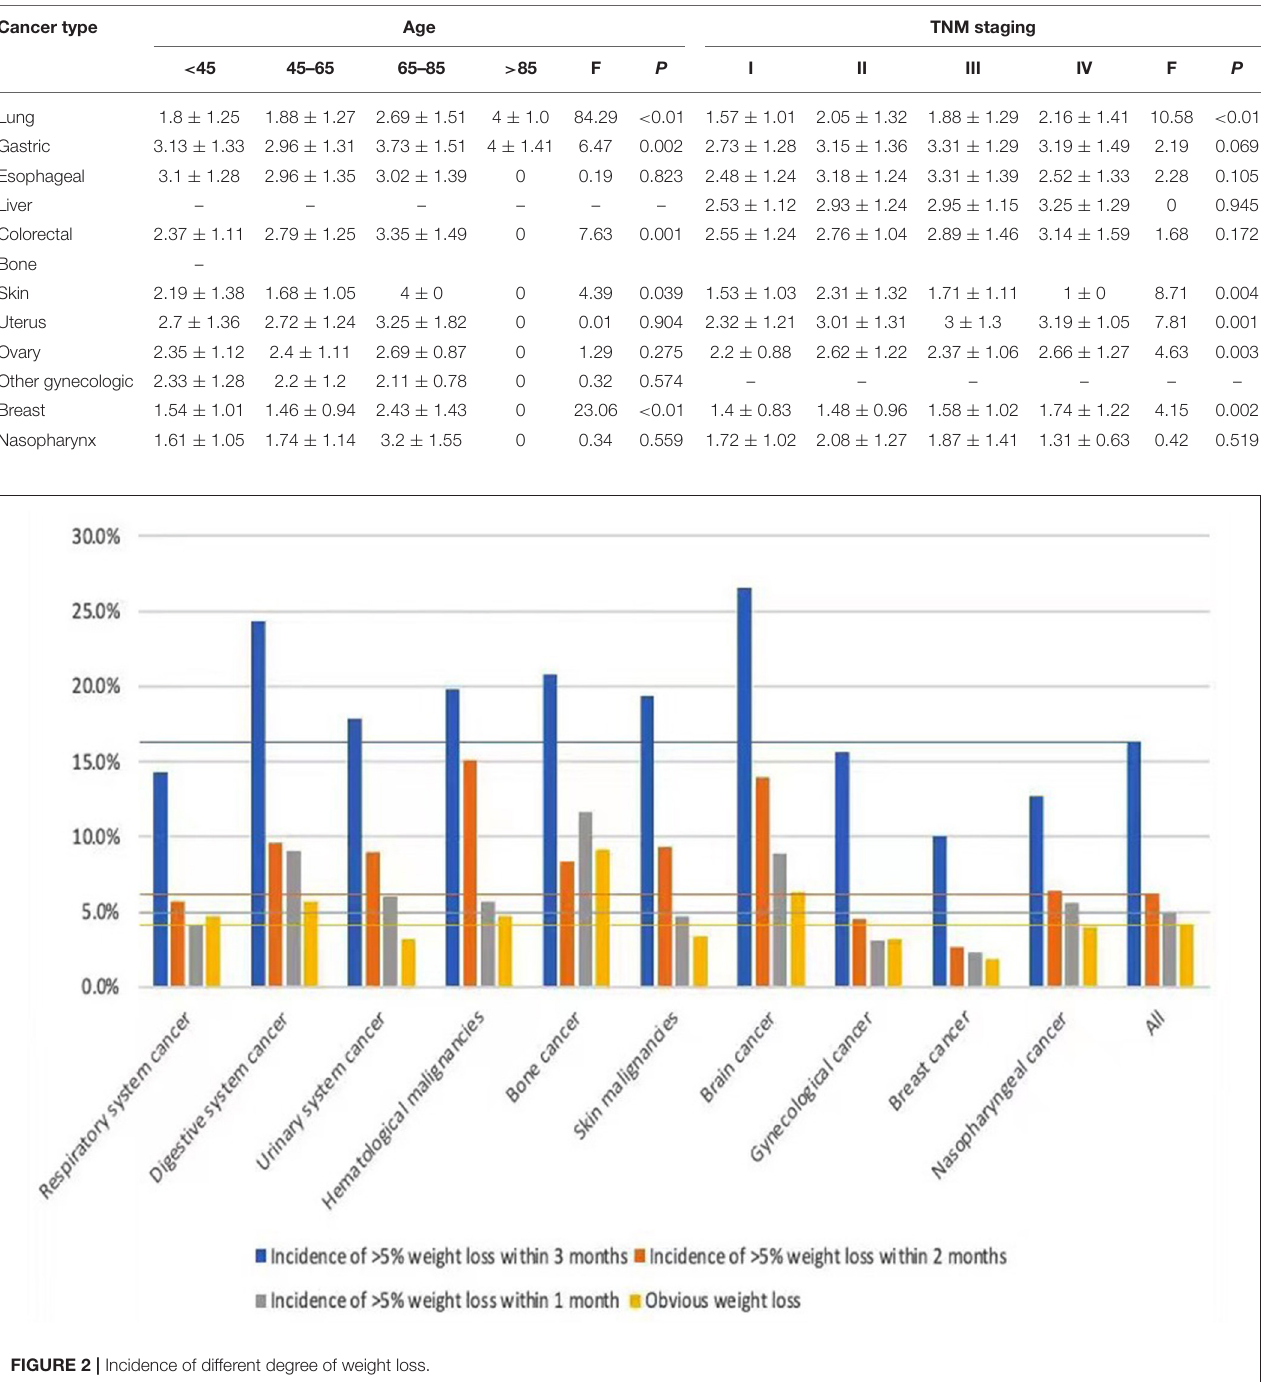
FIGURE 2 | Incidence of different degree of weight